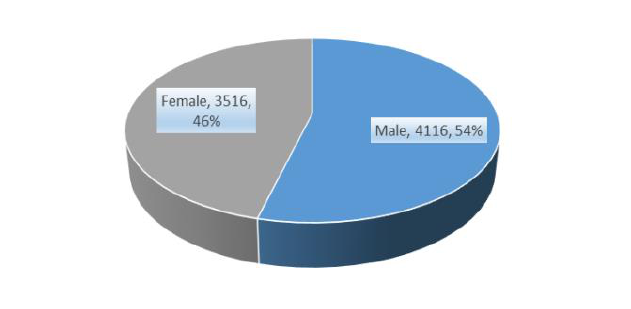
Fig. 2: Citizen's count by sex (N=7632)